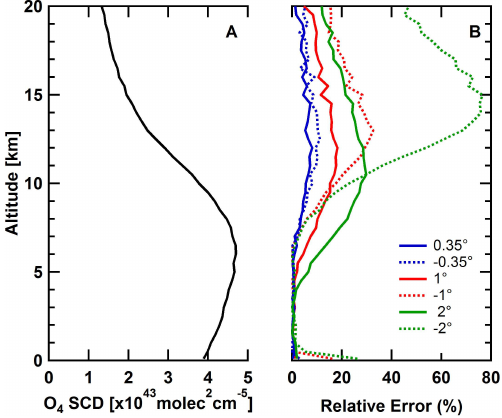
Fig. 6. (A) Vertical profile of O 4 SCDs calculated for 0 ◦ EA at 477nm using McArtim (US standard atmosphere with exponential aerosol extinction profile with extinction of 0.2km − 1 at the ground and 2.5km scale height). (B) Relative error in O 4 SCDs for 0.35 ◦ (blue), 1 ◦ (red) and 2 ◦ (green) pointing error of the telescope at 0 ◦ EA. The solid and dashed lines represent angles above and below the horizon,